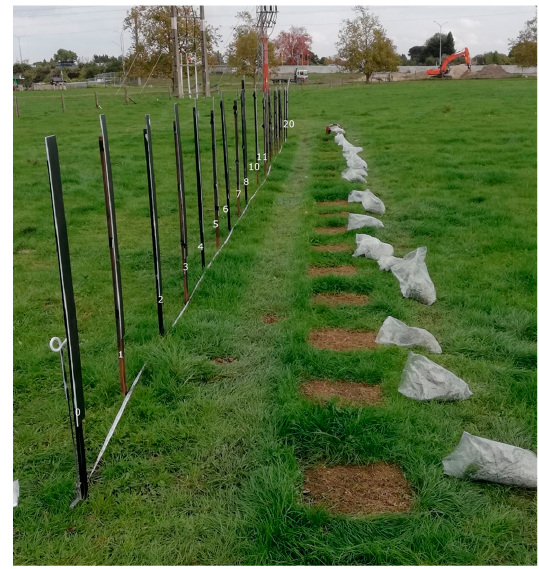
Figure 6. Transect 1 with posts at 0, 1, ... , 8, 10, 11, ... , 20 m. Biomass measured was measured from